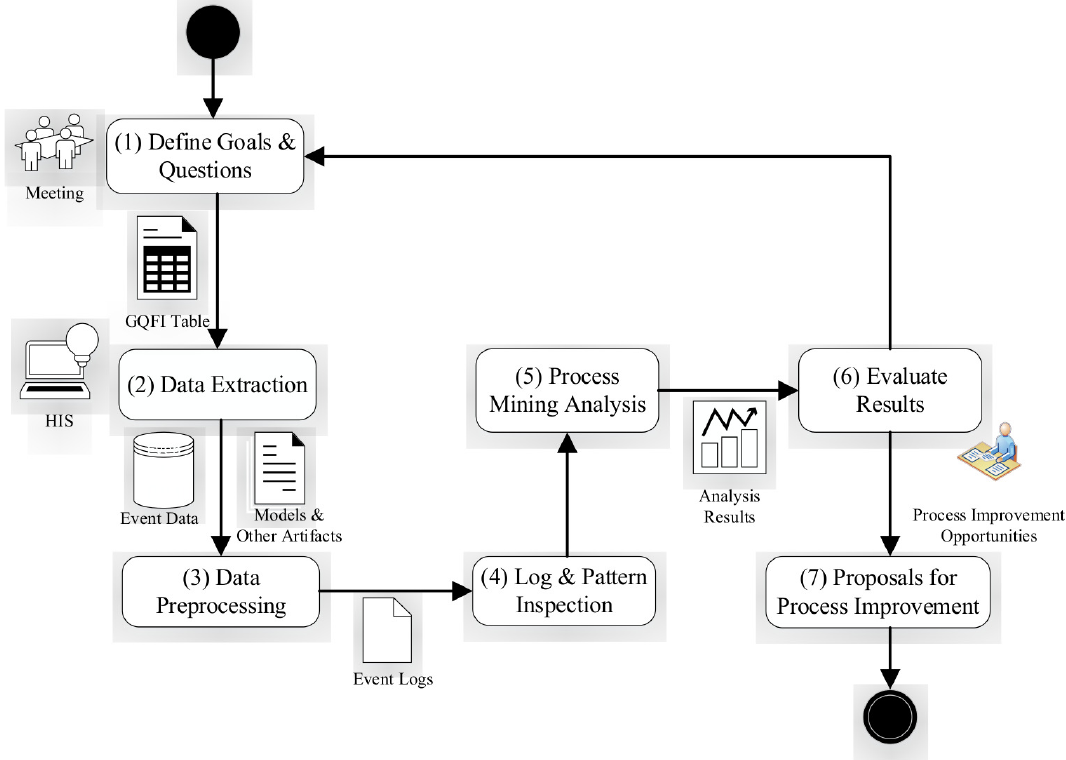
Figure 1. Proposed